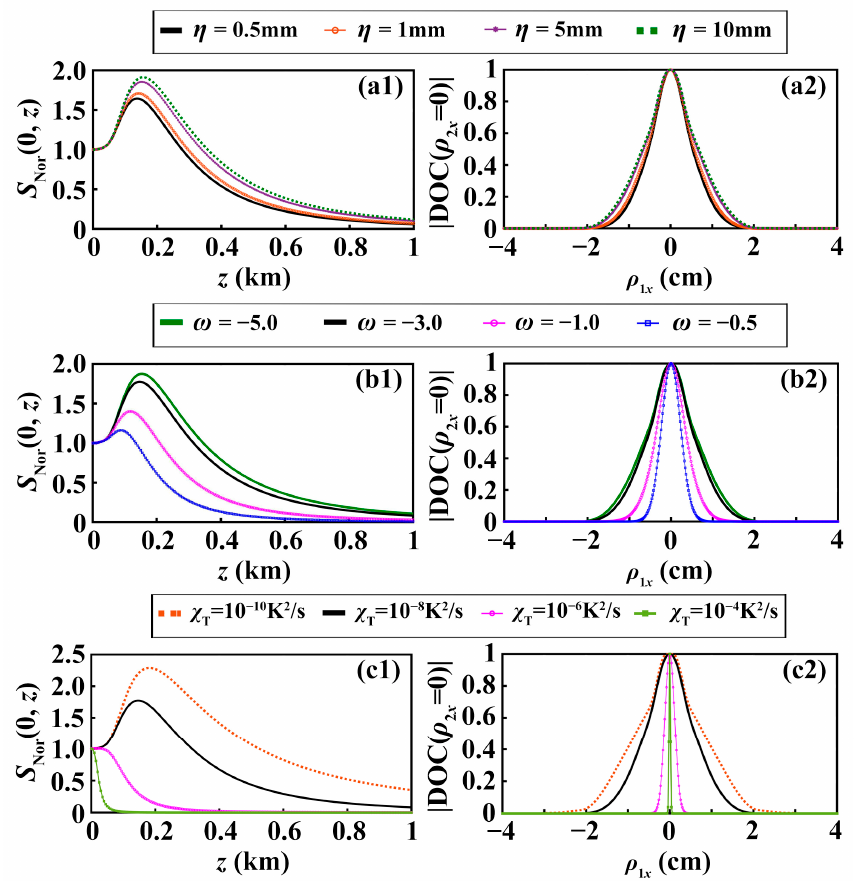
Figure 7. Normalized on-axis intensity of the LNUC beam propagating in oceanic turbulence and the cross-line ( ρ 2 x = 0) of the absolute value of the spectral DOC at z = 150 m for different oceanic turbulence parameters: ( a ) the Kolmogorov inner scale; ( b ) the relative strength of temperature to salinity undulations; ( c ) the dissipation rate of mean ‐ square temperature.